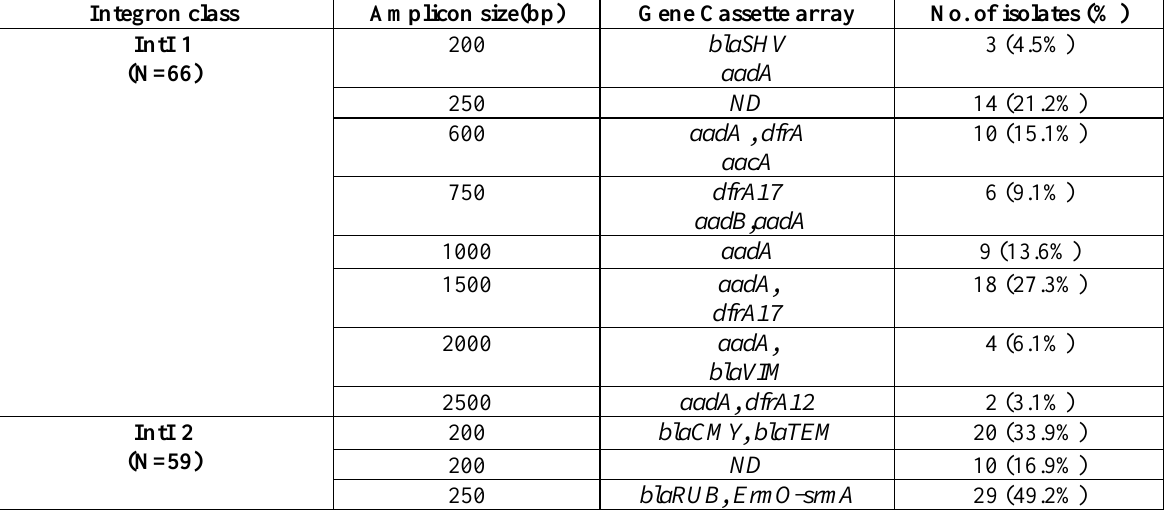
Table 3. Characterization of gene cassette arrays according to the amplicon size of class 1 and 2 integron variable regions in the P. mirabilis isolates.